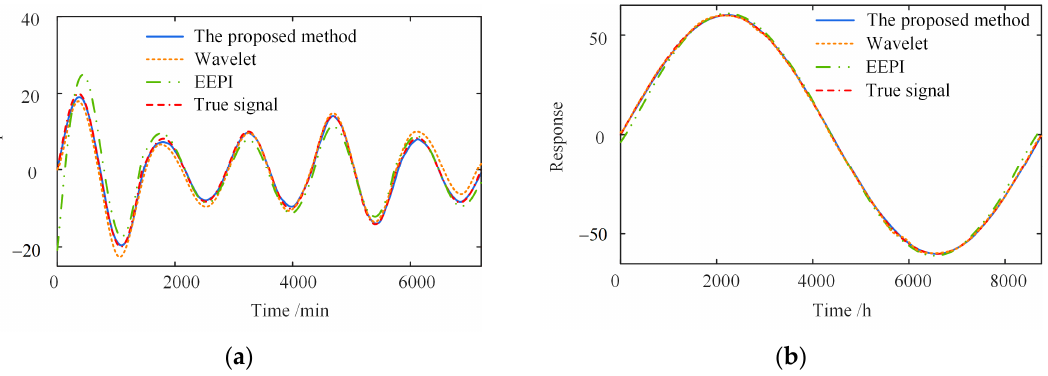
Figure 8. Curve of the optimal ε g year.